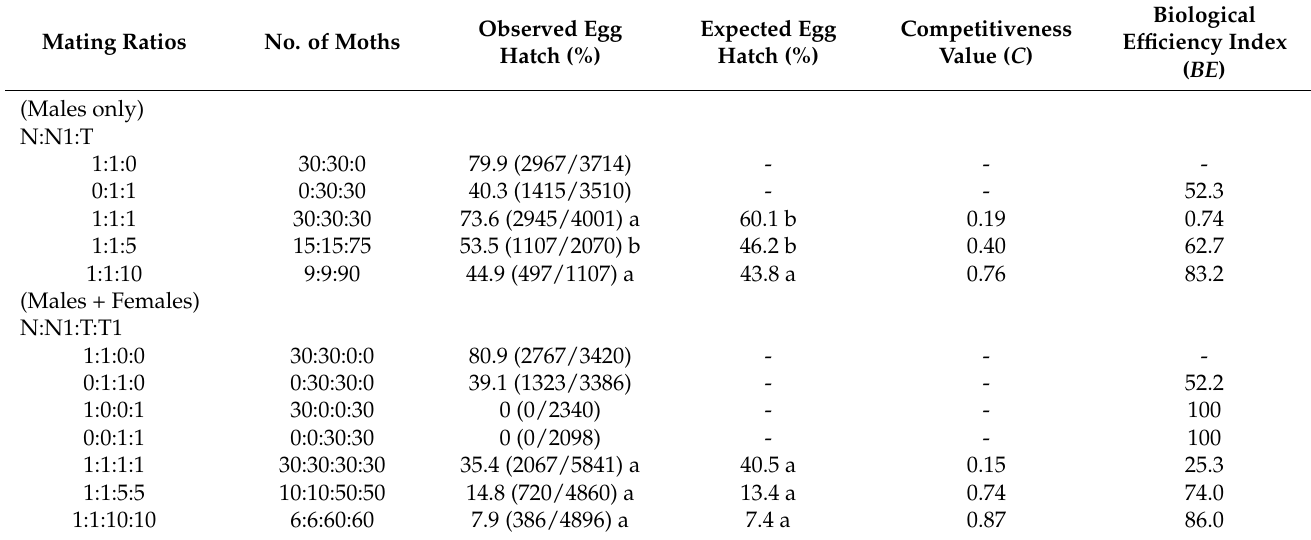
Each ratio was repeated three times. Numbers between parentheses are hatched eggs/total laid eggs at each ratio. Percentages in row followed by the same letter are not significantly different ( p ≤ 0.05, Z test).